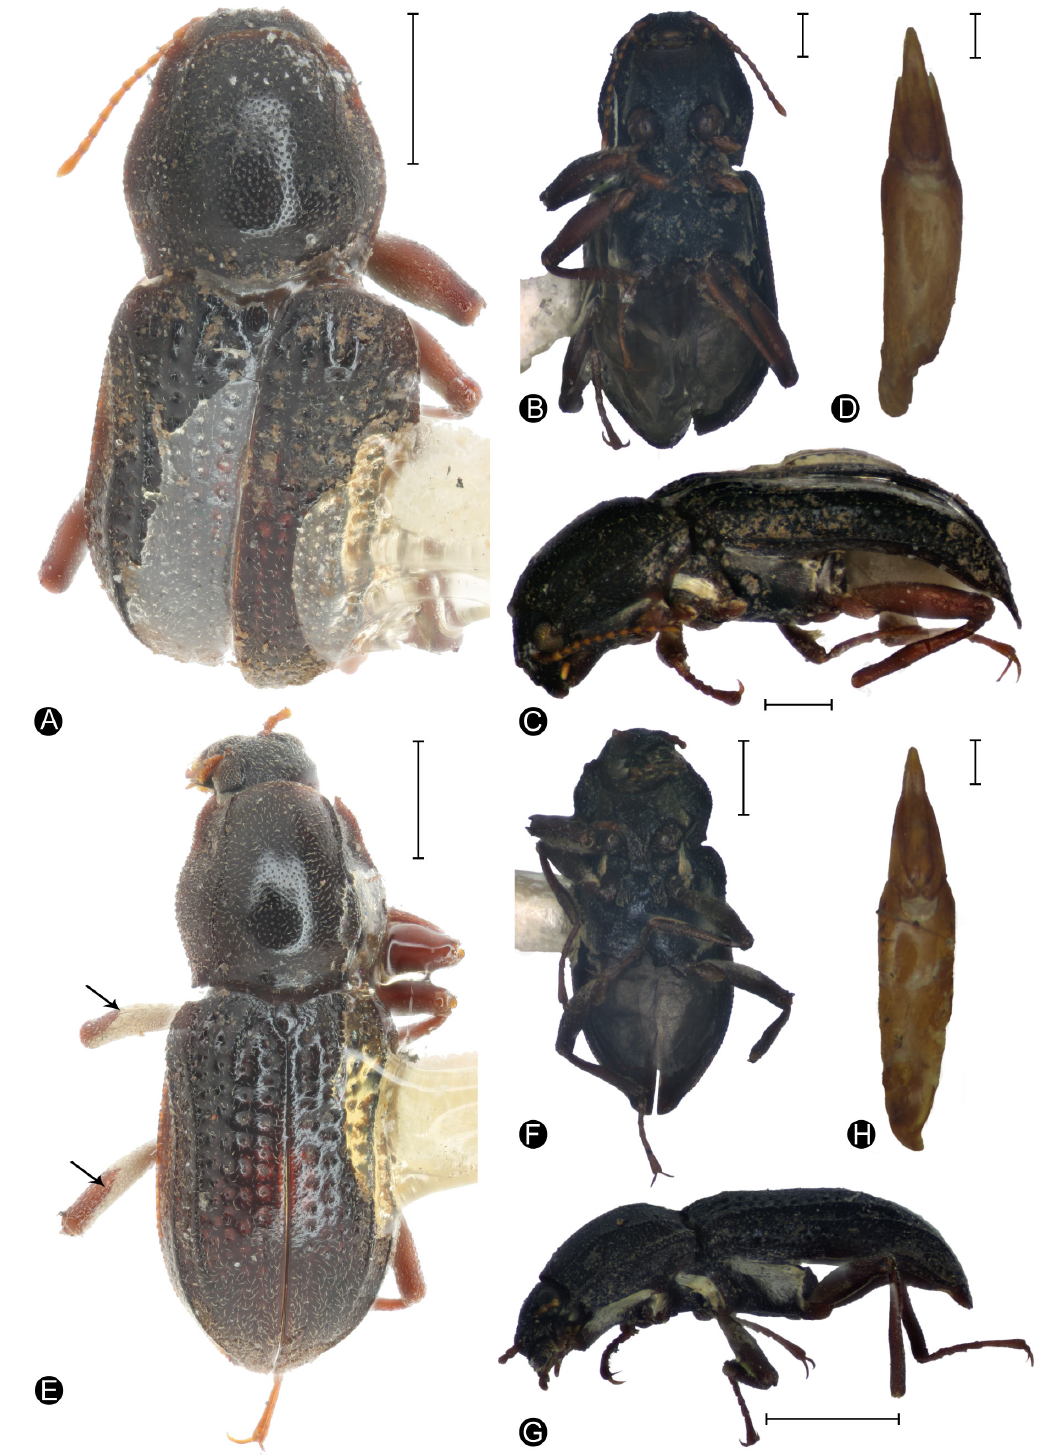
Fig. 1. A – D . Spanglerelmis femoralis (Hinton, 1940) gen. et comb. nov., holotype, ♂ (NHMUK 010583892). A – C . Habitus. A . Dorsal view. B . Ventral view. C . Lateral view. D . Aedeagus in ventral view. E – H . Microcylloepus ochus Hinton, 1940, holotype, ♂(NHMUK 010583871). E – G . Habitus. E . Dorsal view (arrows showing the pattern of tomentum on femur). F . Ventral view. G . Lateral view. H . Aedeagus in ventral view. Scale bars: A–C, E–G = 0.5 mm; D, H = 0.1